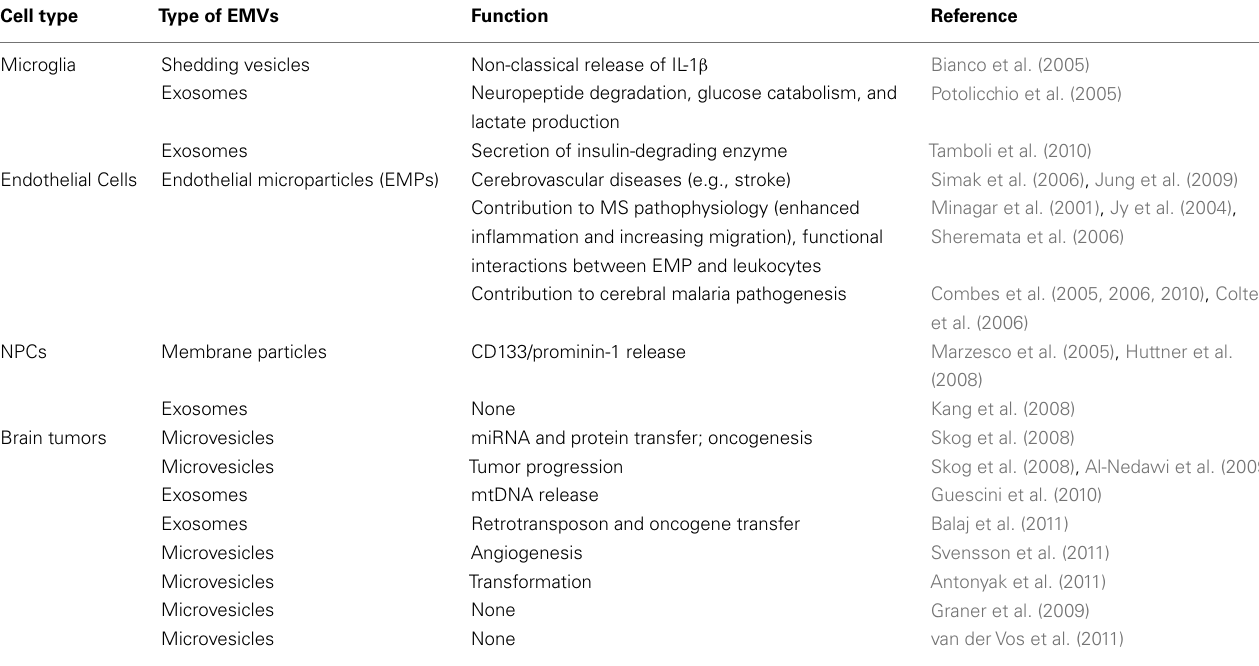
Table 1 | Extracellular membrane vesicles in the